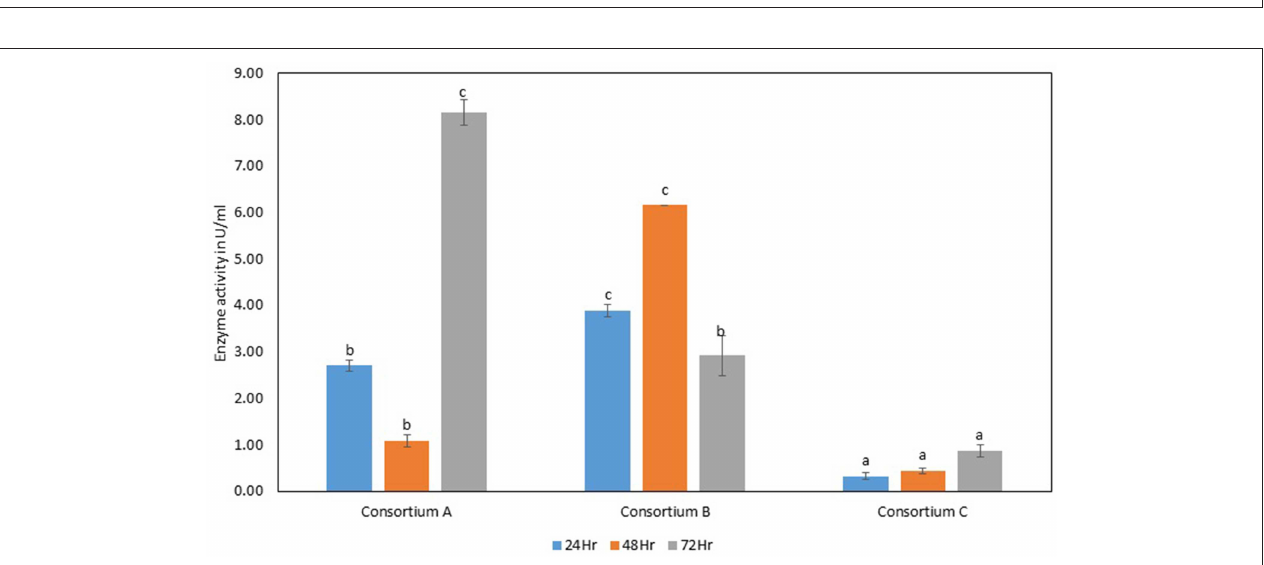
FIGURE 10 | β -glucosidase activity of different strains. Values are the mean ± SE (standard error). Mean values in each bar with the same alphabet superscript(s) do not differ significantly, but different alphabet superscript is showed significantly different between each treatment by Duncan post hoc test ( p ≤ 0.05).